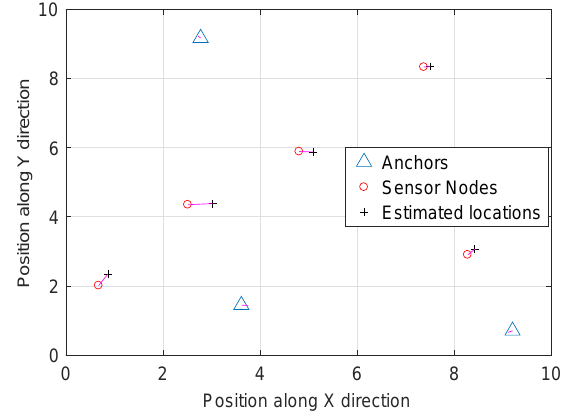
Figure 5. Mean square error for m =3 and n = 5.